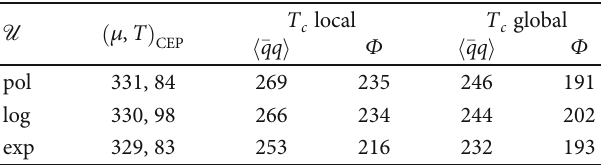
Table 2: Critical temperatures (MeV) at μ = 0 for T